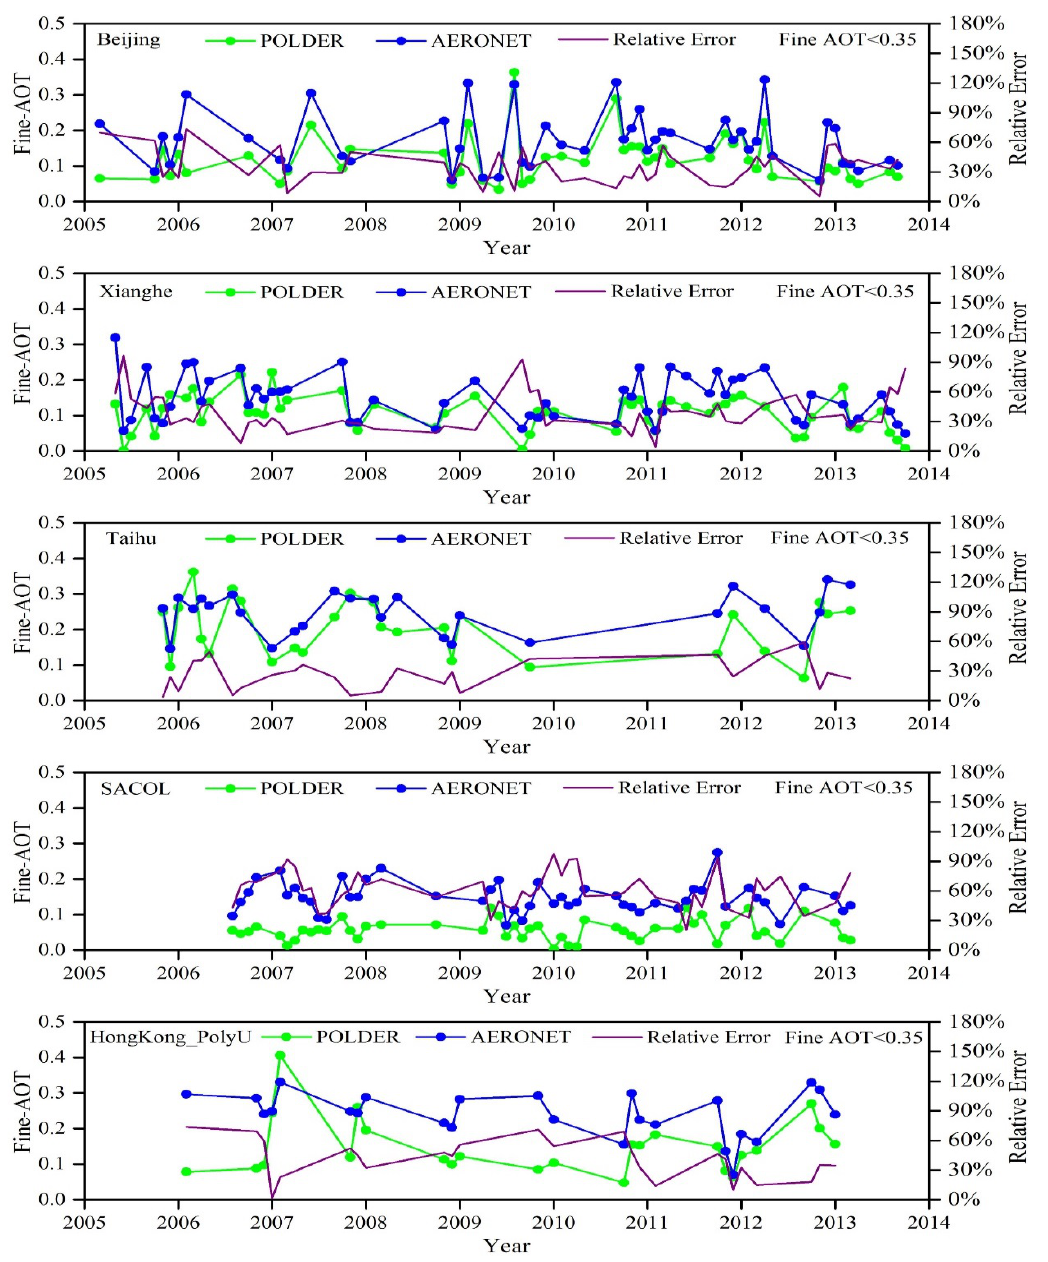
Figure 4. Identical to Figure 3 but for daily mean fine AOTs lower than